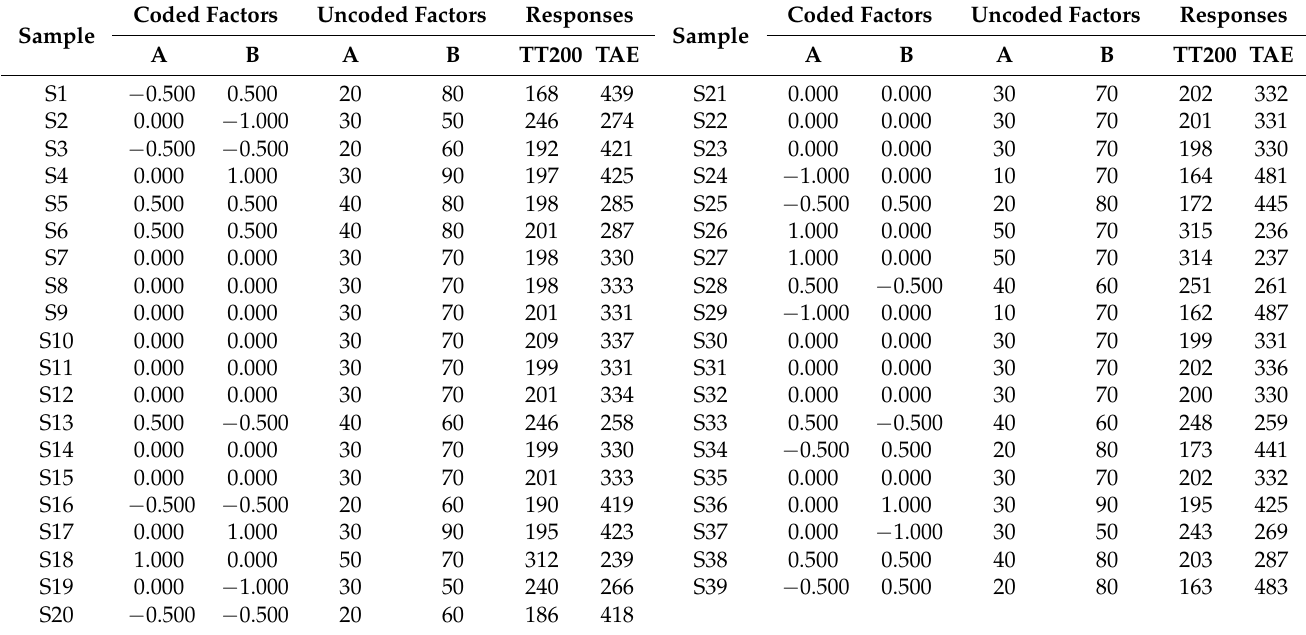
Table 3. Design matrix and response value for the fire resistance